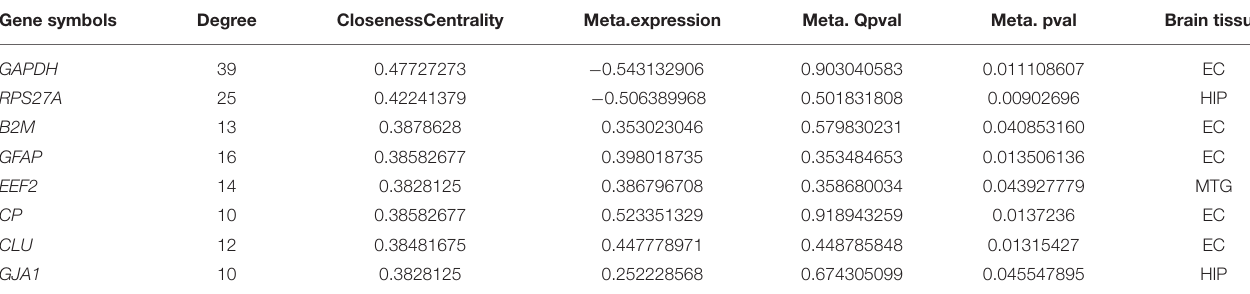
TABLE 6 | The hub genes identified from the meta-analysis DEGs. Gene symbols